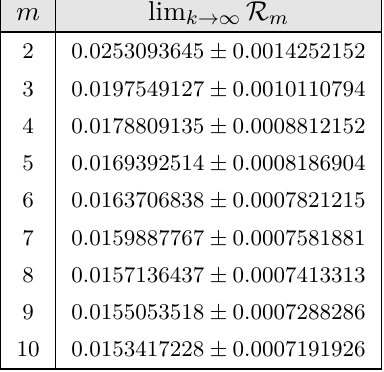
Figure 18. Variation of Rényi entropies for the state | 6 1 # T 2 , 2 i with k .